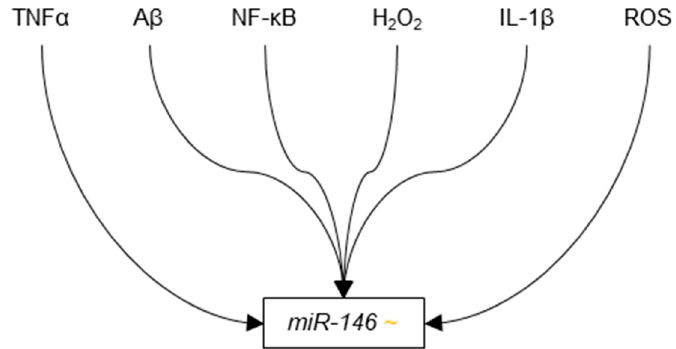
Figure 7. Regulation of miR-146. miR-146 expression is induced by multiple inflammatory species (Tumor necrosis factor (TNF)- α (TNF α ), nuclear factor kappa-B (NF- κ B), H 2 O 2 , interleukin (IL)-1 β (IL-1 β ), and reactive oxygen species (ROS)), as well as A β . The yellow tilde (~) indicates the debated levels of miR-146 in AD brain.